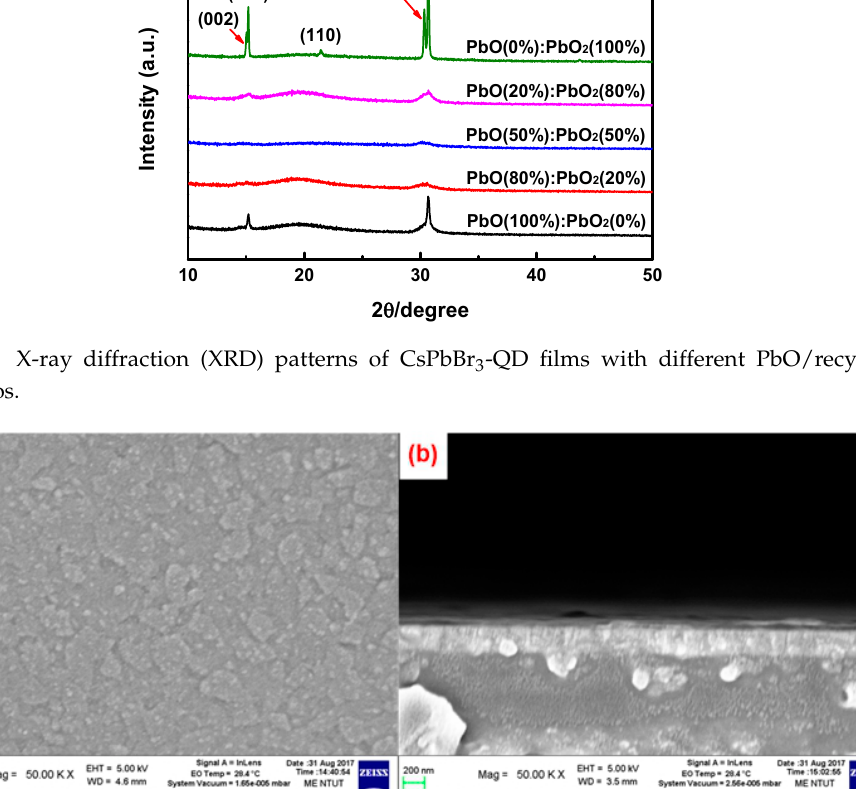
Figure 2. X-ray diffraction (XRD) patterns of CsPbBr 3 -QD films with different PbO/recycled PbO 2 ratios.